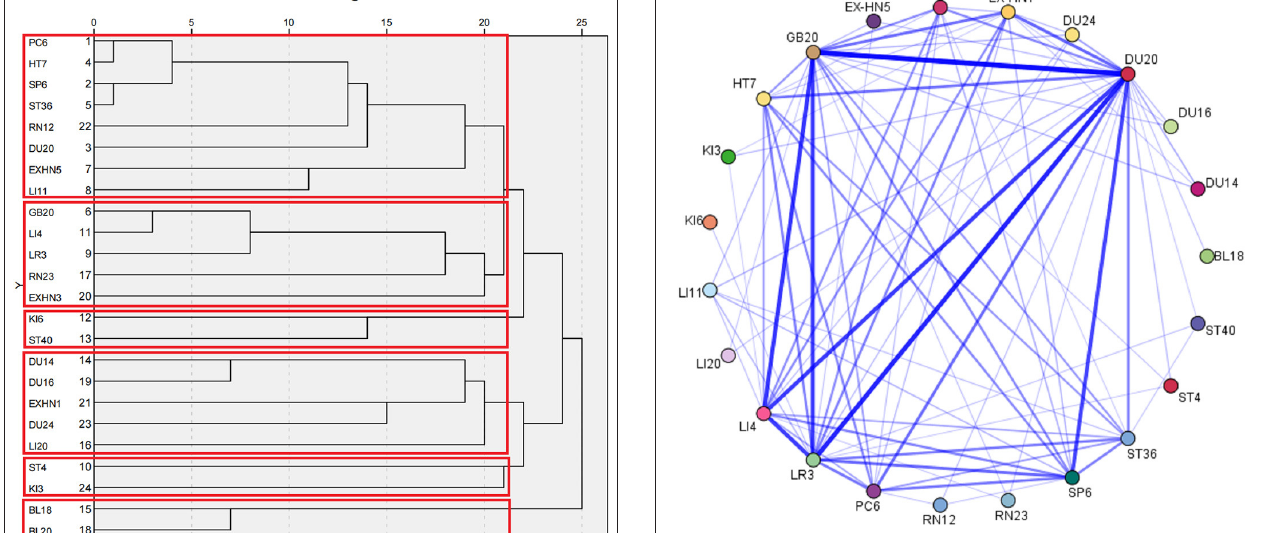
TABLE 5 | Association rules of acupoints for TD treatment.